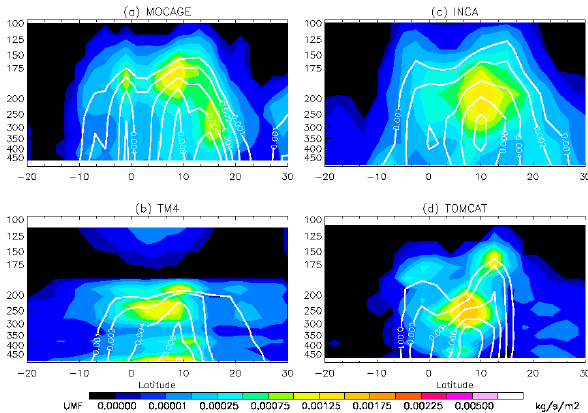
Fig. 2. August 2006 latitude-pressure cross-sections of convective mass fluxes averaged over 0 ◦ W–30 ◦ E from (a) MOCAGE (b) TM4 (c) INCA and (d) p-TOMCAT. Color contours represent the detrain- ment mass fluxes (kg/m 2 /s) and solid white contours the updraft mas fluxes (0.001, 0.002, 0.004, 0.006, 0.008, 0.016kg/m 2